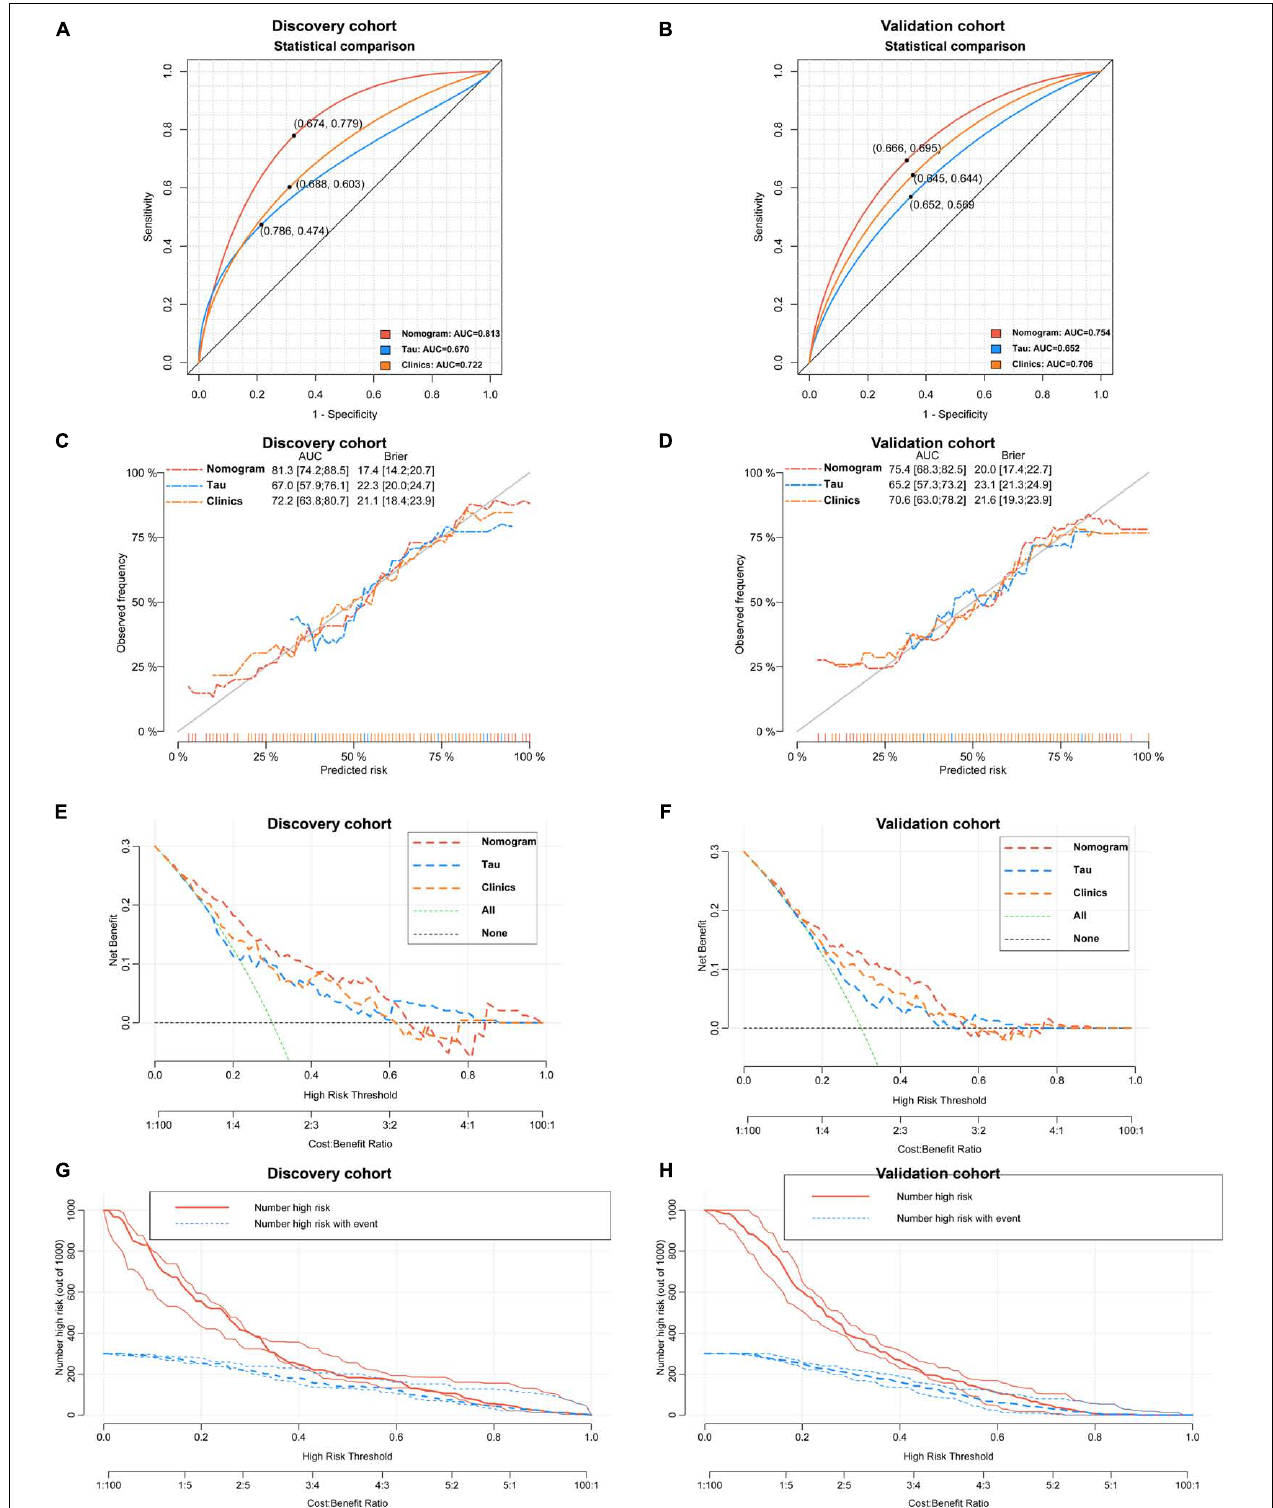
FIGURE 8 | Verification of the predictive performance and clinical applicability of the nomogram for differentiating aMCI and AD. A nomogram outperforms total Tau and Clinical model for predicting the probability of AD in discovery cohort [ (A) 0.813 vs. 0.670 and 0.722, P < 0.05] and validation cohort [ (B) 0.754 vs. 0.652 and 0.706, P < 0.05]. Calibration curves of three models in discovery cohort (C) and validation cohort (D) . Decision curves analyses of three models in discovery cohort (E) and validation cohort (F) . Clinical impact curves of nomogram model in discovery cohort (G) and validation cohort (H) .